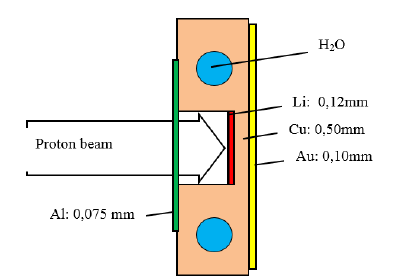
Figure 1: Scheme of Li target, Au sample and Cu backing used in the activations (and Al foil for the MNS